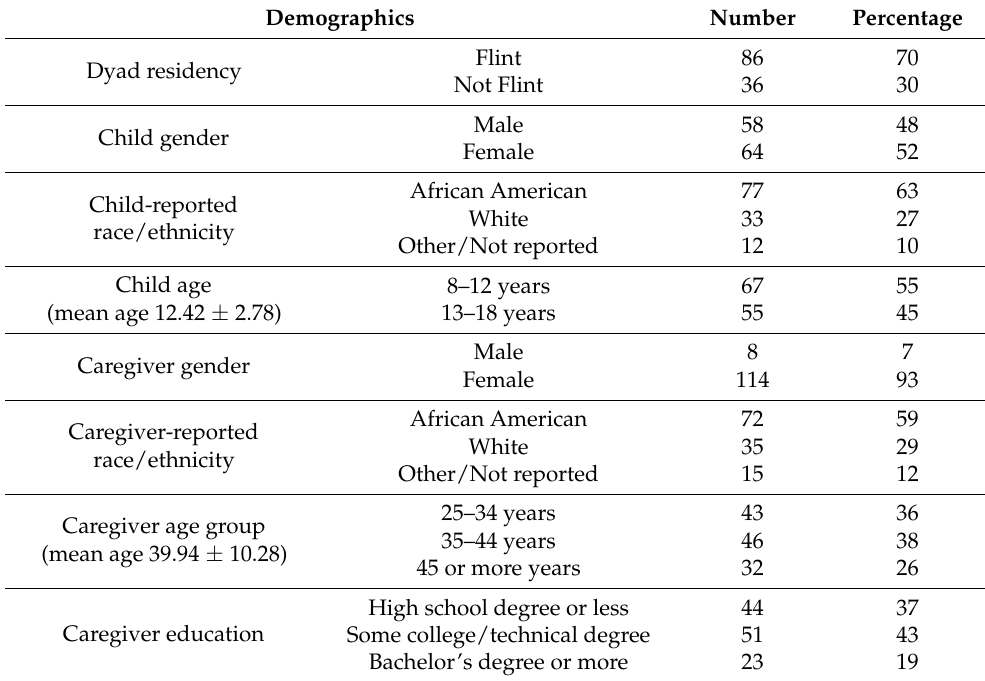
Table 1. Child and caregiver